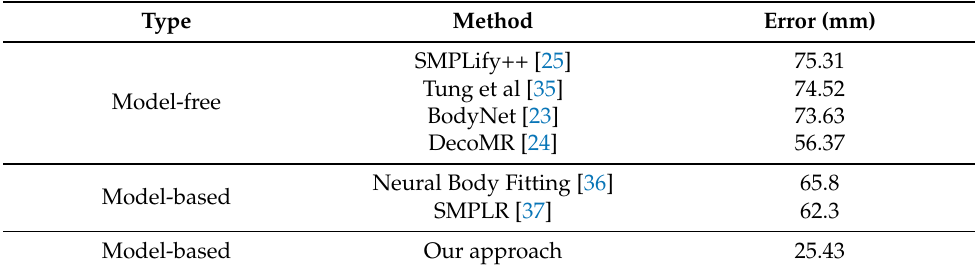
Table 1. Quantitative results on the SURREAL dataset in terms of MPVE (mm).